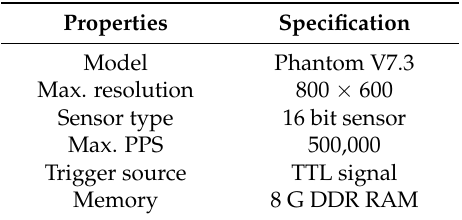
Table 3. Specifications of the high-speed camera.